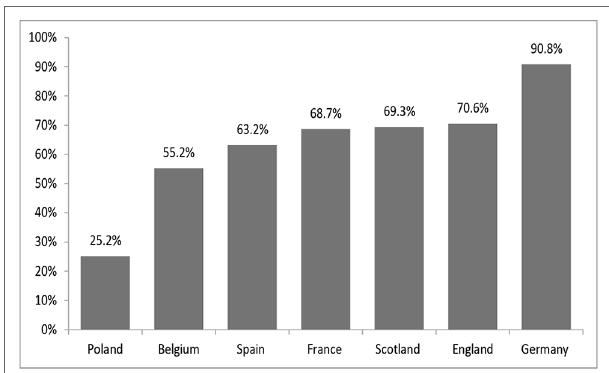
FIGURE 2 | Percentage of reimbursed orphan drugs (all) in analyzed countries.